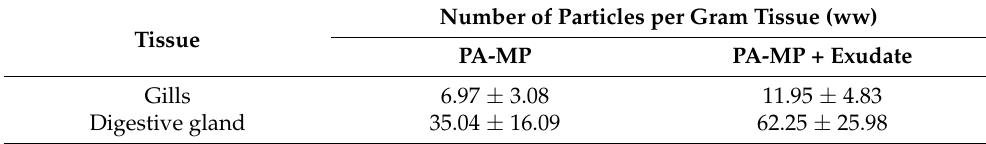
Table 1. Number of polyamide microplastics (PA-MPs) per gram of tissue (gills and digestive gland) in Mytilus galloprovincialis exposed to PA-MPs and PA-MPs together with A. armata exudate. All values are presented mean ± SEM. ww = wet